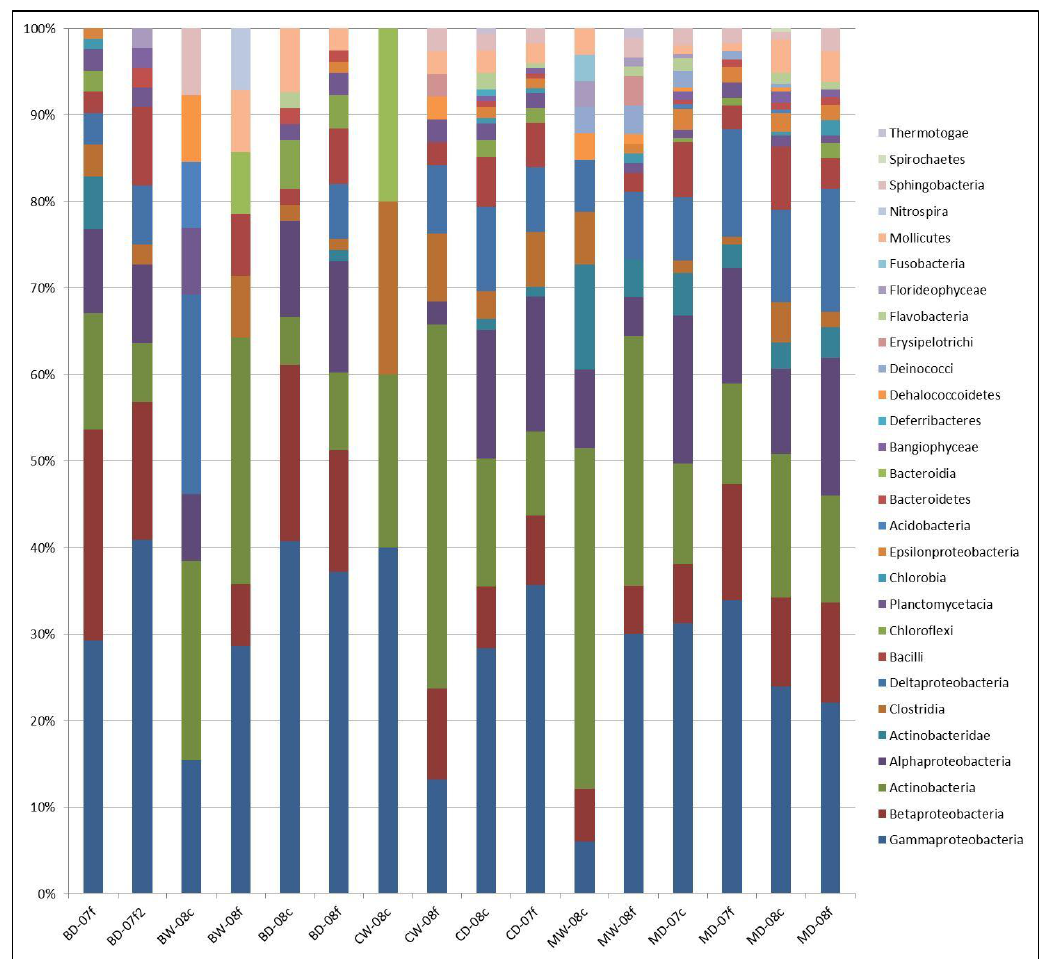
Figure 2. Percent abundance of bacterial class presented from all three sites. The x axis are sample site abbreviations that correspond to the naming convention in Table 1 (M = Marks Creek, B = Bear Creek, C = Crabtree Creek, W = wet; D = dry. Numeric code is the year of collection. Lower case letters depict sediment size; c= coarse; f =